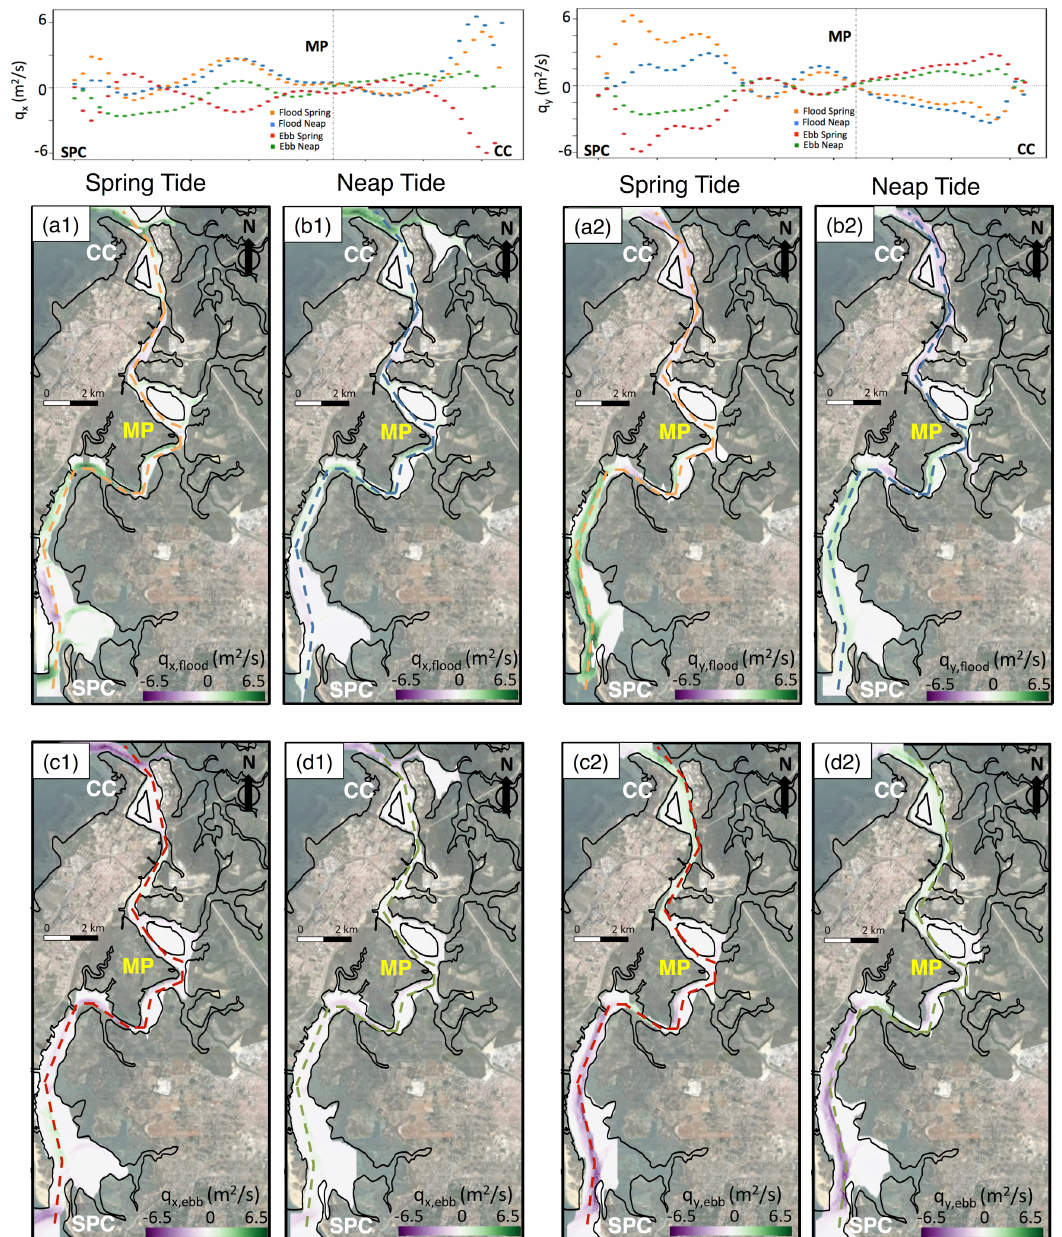
Figure 7. ( a , b ) Along channel variations of the flow rates per unit width q x and q y along the x , y coordinates, respectively, when the maximum flood and ebb conditions during the simulation time are attained during spring and neap tides ( q x is positive towards the East, q y is positive towards the North). Spatial distribution of q x during maximum flood for spring ( a1 ) and neap ( b1 ) tides, and spatial distribution of q y during maximum flood for spring ( a2 ) and neap ( b2 ) tides. ( c1 , d1 ; c2 , d2 ) same as above for the maximum ebb tide. Orange, blue, red and green dashed lines correspond to flood spring, flood neap, ebb spring and ebb neap,